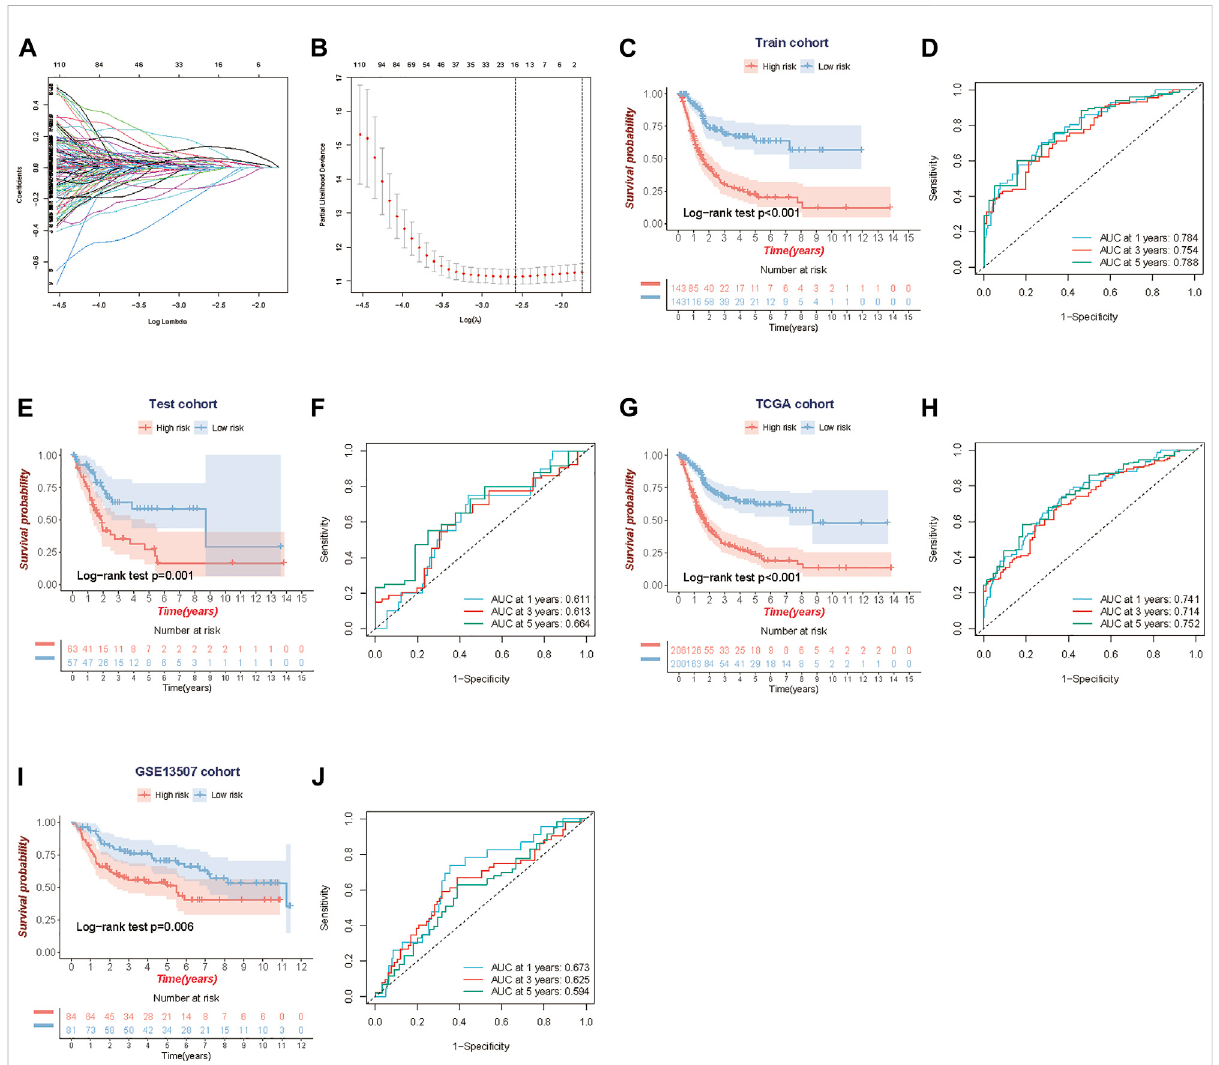
FIGURE 2 Construction and validation of the TME-related 10-gene risk score (RS). (A,B) LASSO regression analysis and partial likelihood deviance on the prognosticgenes. (C,D) Kaplan-MeiersurvivalcurvesandROCcurveforTCGAtraincohort. (E,F) Kaplan-MeiersurvivalcurvesandtheROCcurvefor TCGA test cohort. (G, H) Kaplan-Meier survival curves and ROC curve for the whole TCGA cohort. (I,J) Kaplan-Meier survival curves and ROC curve for GSE13507